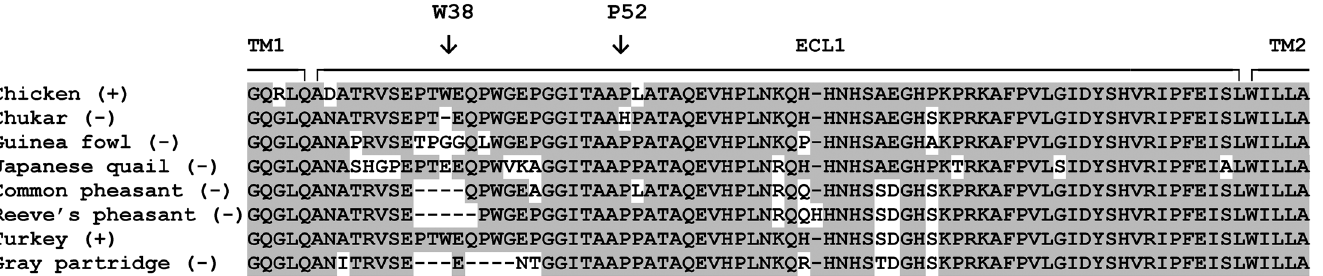
Fig 3. NHE1 allele in gray partridge contains deletion of W38 resembling the ALV-J resistant species in galliforms. The deduced gray partridge amino-acid sequence of ECL1 corresponding to chNHE1 amino-acids 23 to 104 are aligned to the sequences of eight galliform species analyzed previously (Ku č erová et al., 2013). The susceptibility or resistance of galliform species is denoted (+) or (-), respectively. The borders between ECL1 and putative transmembrane domains TM1 and TM2 are shown. The W38 and P52 amino acid residues are denoted by vertical arrows. Amino acids matching the consensus sequence are on a gray background.